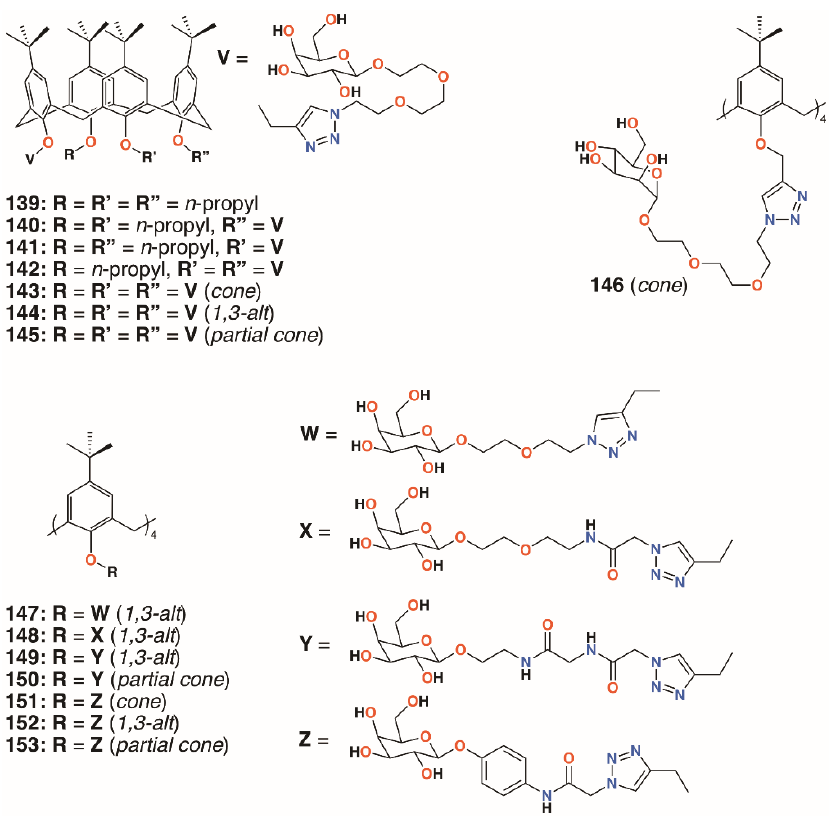
Figure 22. Imberty’s glycosylated calixarenes.